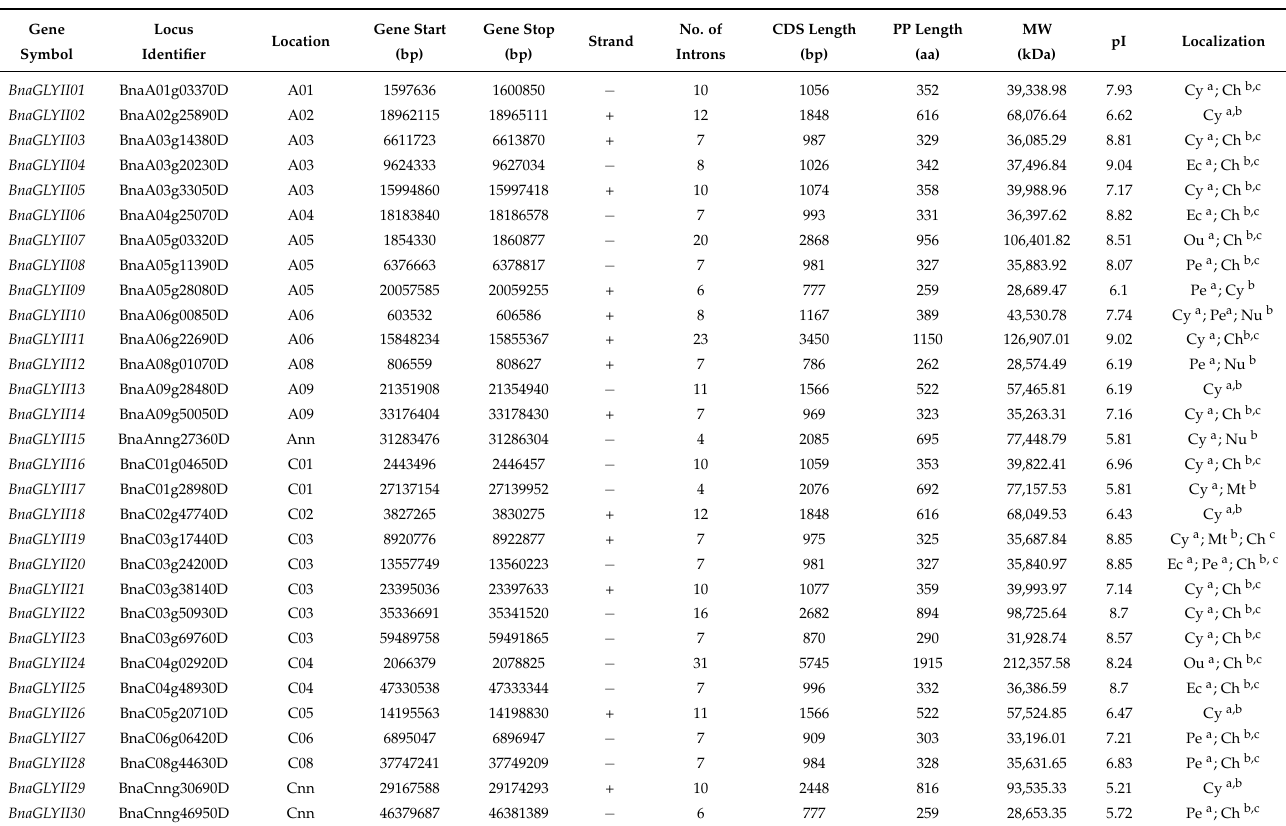
length of 1216 aa and a molecular weight of 134.9 kDa, while BnaGLYI34 encodes for the smallest protein with a polypeptide length of 108 aa and a molecular weight of 12.2 kDa (Table 1). The isoelectric point (pI) of BnaGLYI proteins vary from 4.78 (BnaGLYI08) to 8.86 (BnaGLYI06). Most of the BnaGLYI members showed acidic pI value, and only four proteins (BnaGLYI02, BnaGLYI05, BnaGLYI06 and BnaGLYI23) showed obvious alkalinity pI value (around 8.0) (Table 1). Moreover, there were also four members (BnaGLYI04, BnaGLYI19, BnaGLYI24 and BnaGLYI31) showing a basic pI value (Table 1). Sub-cellular localization of all identified BnaGLYI proteins were analyzed using three tools (CELLO, Wolf-pSORT and ChloroP). The results predicted that all BnaGLYI, except BnaGLYI15, were localized in cytoplasm. However, the TargetP predicted that most BnaGLYI were localized in the chloroplast, followed by the cytoplasm, nucleus, mitochondrion and cytoskeleton (Table 1). Similarly, the CDS length of BnaGLYII genes also had very wide ranges, from 777 bp tein (259 aa, 28.57 kDa), while BnaGLYII24 was the largest protein (1915 aa, 212.36 kDa) (Table 2). The pI value of BnaGLYII proteins varied from 5.21 (BnaGLYII29) to 9.04 (BnaGLYII04). Most of the BnaGLYII proteins showed alkalinity with a pI value around or more than 7.0, and only seven BnaGLYII proteins had an acidic pI value, includ- ing BnaGLYII09, BnaGLYII12, BnaGLYII13, BnaGLYII15, BnaGLYII17, BnaGLYII29 and BnaGLYII30 (Table 2). Sub-cellular locations of BnaGLYII proteins were different from BnaGLYI proteins. BnaGLYII protein members were localized in different sub-cellular com- partments, such as cytoplasm, chloroplast, extracellular matrix, outermembrane, periplasm, nucleus and mitochondrion (Table 2). Table 2. Basic characteristics of BnaGLYII genes identified in Brassica napus L.